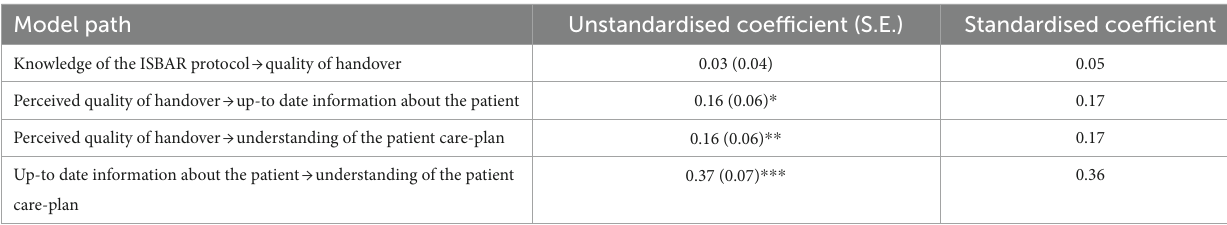
TABLE 3 Path coefficients. Model